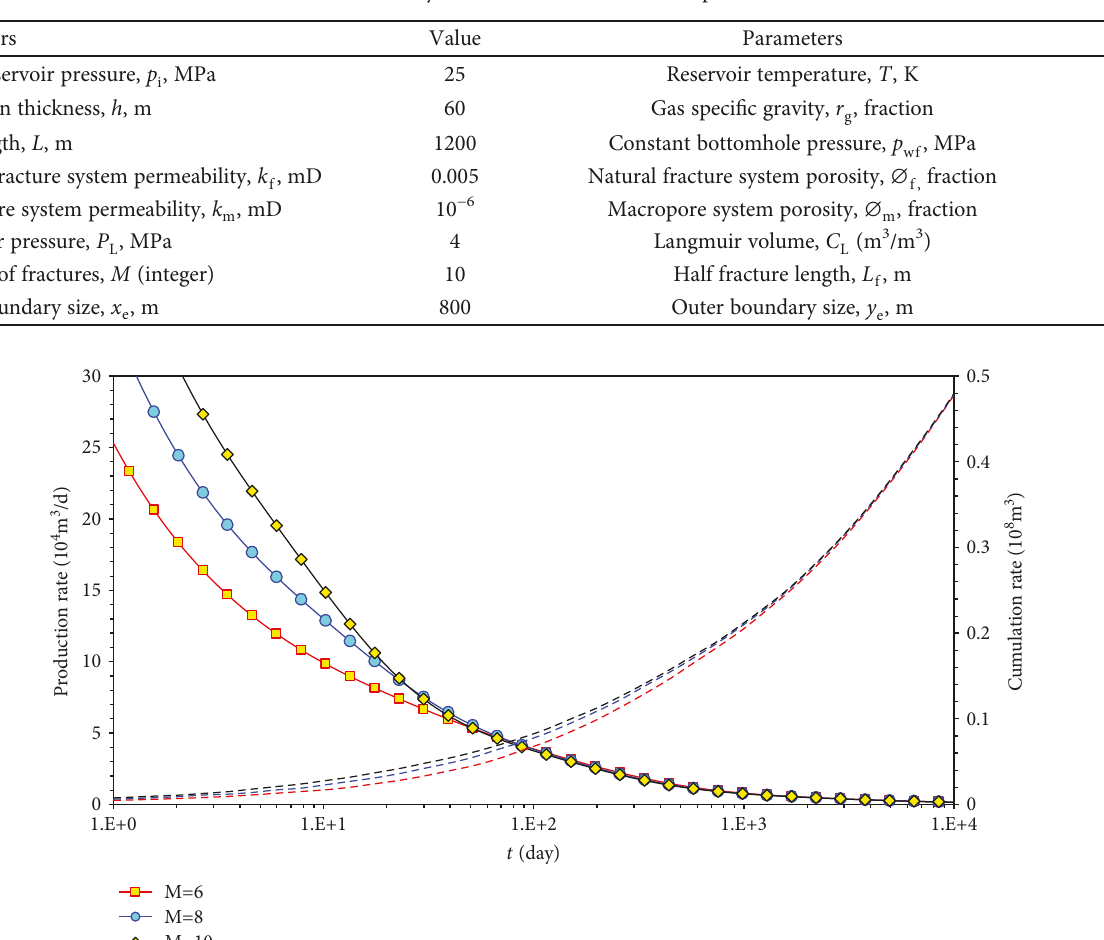
Figure 8: In fl uence of fracture number on well production